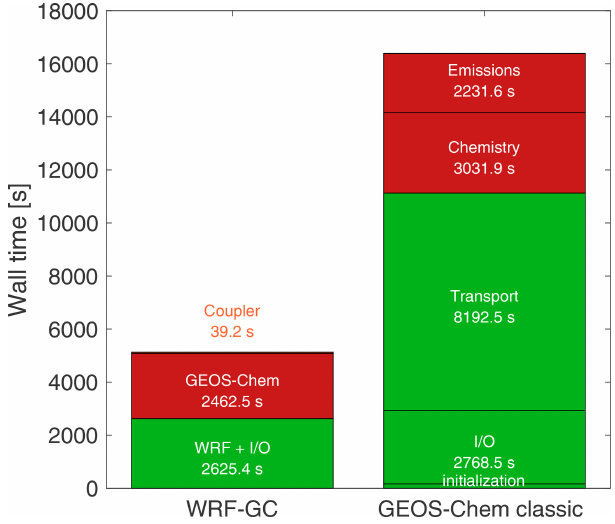
Figure 6. Comparison of wall time for the WRF-GC model (v1.0) and the GEOS-Chem Classic nested-grid model